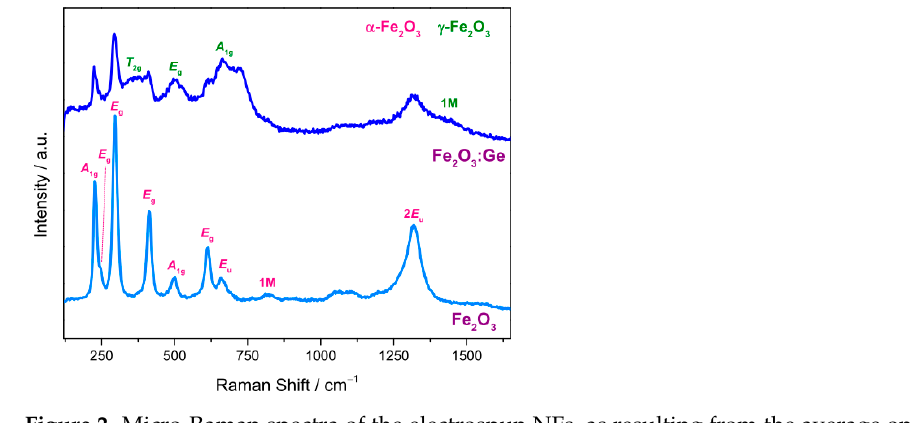
Figure 2. Micro-Raman spectra of the electrospun NFs, as resulting from the average on different